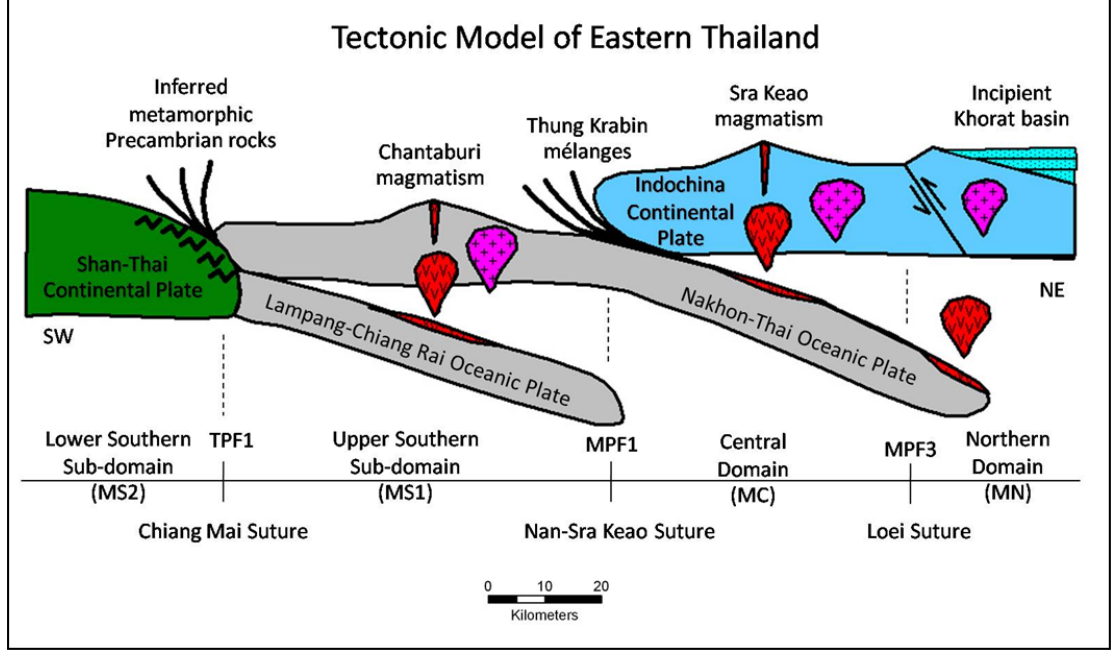
Figure 6. Schematic tectonic model of eastern Thailand showing tectonic blocks, sutures, and settings during the Early Mesozoic times, based on the interpretation of geophysical, geological results from the current (see Figure 4) and previous